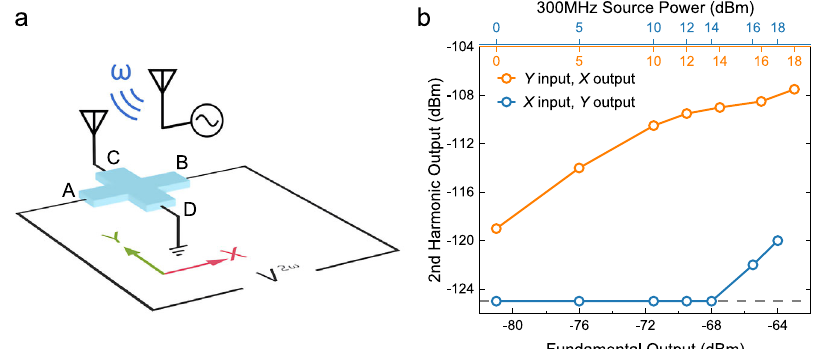
Fig. 5 | Room-temperature wireless microwave frequency doubling based on the NLHE. a Schematic of the experiment setup. A pair of antennas are used to transmit and receive wireless signals. Panel b shows the measured second-harmonic